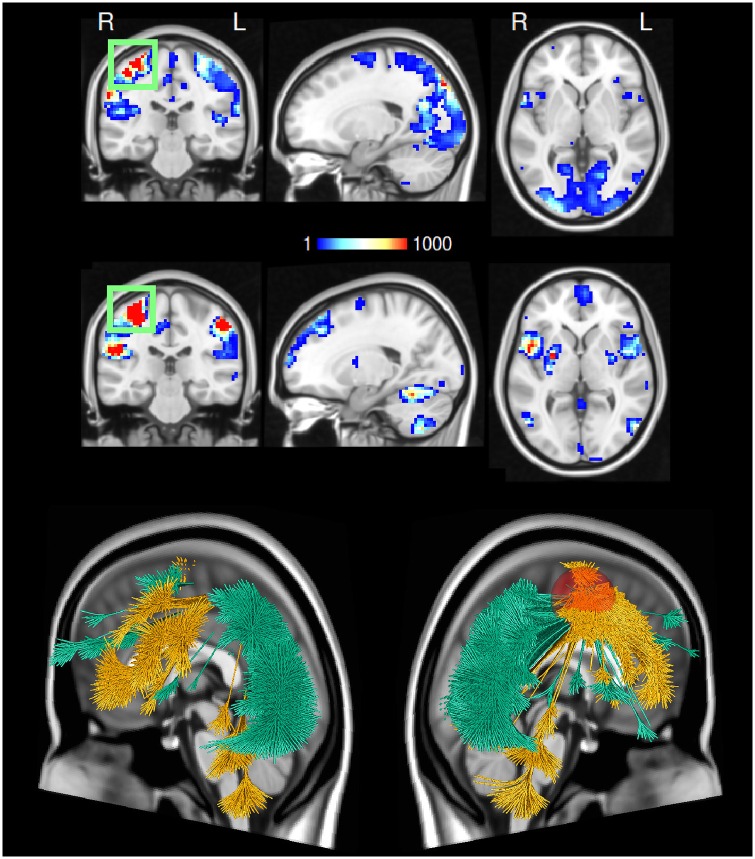
Task-related reconfiguration of the right-hemispheric primary motor cortex.In a TED analysis, a single region may appear in opposite maps because the contrast is computed between edges, not between voxels. Therefore, edges can only appear in one contrast whereas a voxel may serve as an endpoint in two separate edges, where the two edges represent opposite contrasts. So in fact, the same voxel voxel may be part of two different networks that subserve different tasks. In this figure we show the participation of the right primary cortex (hand knob area, marked with a green box) in different networks, depending on the experimental condition, see discussion section. The exact shape of the region of interest is shown in S3 Fig. In the upper panel we display voxels involving all edges featuring a stronger synchronisation with the right primary motor cortex for right hand fingertapping (as compared to left hand tapping). In the lower panel we show the voxels where the synchronisation with the same area is higher for left hand fingertapping (as opposed to right hand tapping). The maps reveal a striking difference in synchronisation of the right primary motor cortex to the rest of the brain: the right hand tapping condition involves stronger synchronisation between the right motor cortex and regions in the visual and parietal cortex. On the other hand, in the left hand condition the same area synchronizes more with bilateral areas in the cerebellum, V5, the putamen and insular cortex and furthermore the medial prefrontal cortex. Below, the same data are shown using a 3D rendering using the software package “braingl” [54, 55]. Here, the synchronisation network of the right primary motor cortex (the red sphere) in the right hand minus left hand contrast is shown in green, the reverse contrast is shown in yellow.